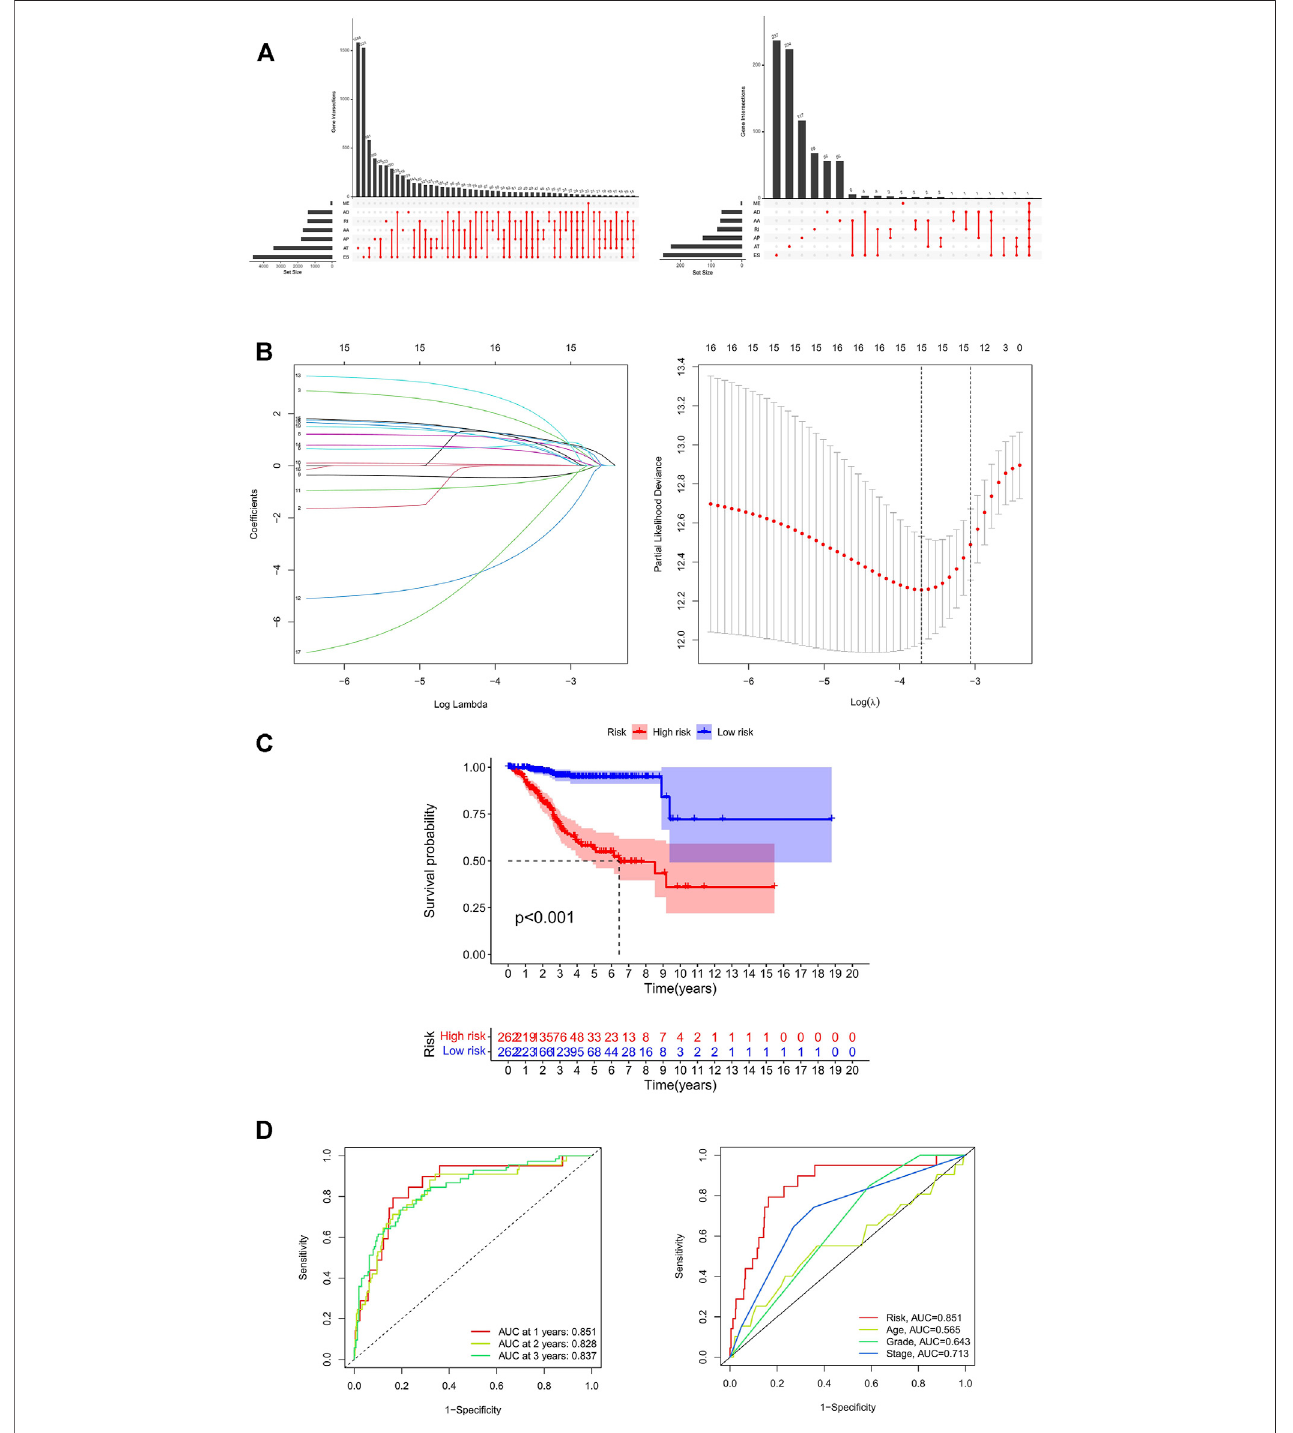
FIGURE 1 | Identi fi cation and prognosis of AS markers in UCEC. (A) The upSet plot of intersections and aggregates among diverse types of AS (left) and survival- associated AS events (right) in UCEC. (B) LASSO coef fi cient pro fi les of survival-associated AS events and 10-time cross-validation for tuning parameter selection in the LASSO model. (C) Kaplan-Meier analysis for OS of UCEC patients. (D) ROC curve in the predicted groups (high- and low-risk groups) by the 11-AS events signature in the UCEC cohort. AA, alternate acceptor; AD, alternate donor; AP, alternate promoter; AT, alternate terminator; ES, exon skip; ME, mutually-exclusive exons; RI, retained intron; UCEC, Uterine Corpus Endometrial Carcinoma.